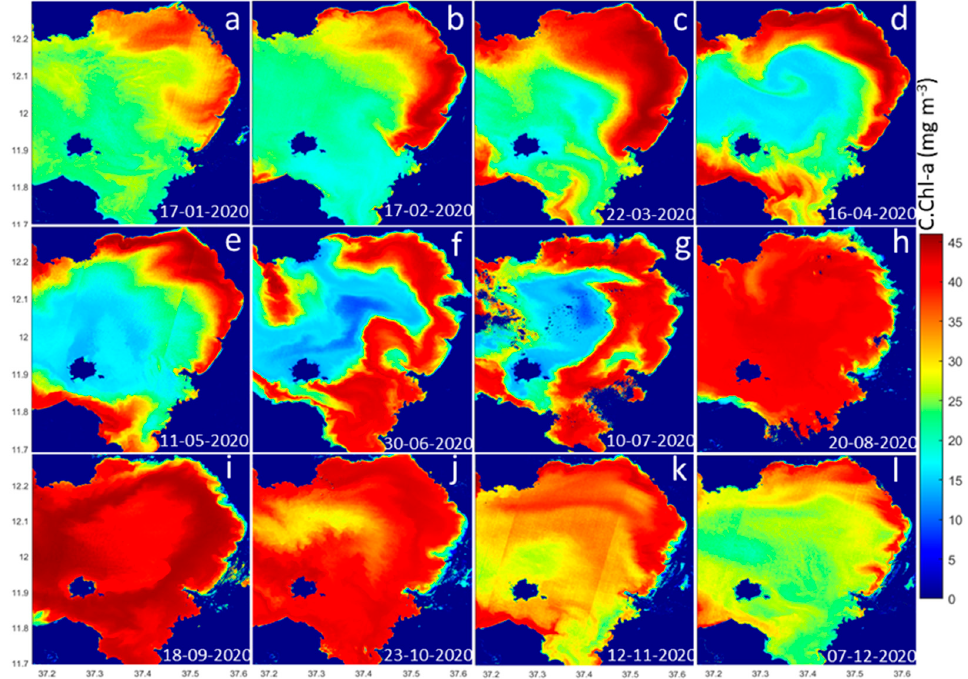
Figure 4. ( a – l ) Chlorophyll-a concentration (Chl-a, mg m − 3 ) in Lake Tana from January 2020 Figure 4. ( a )–( l ) Chlorophyll ‐ a concentration (Chl ‐ a, mg m − 3 ) in Lake Tana from January 2020 to